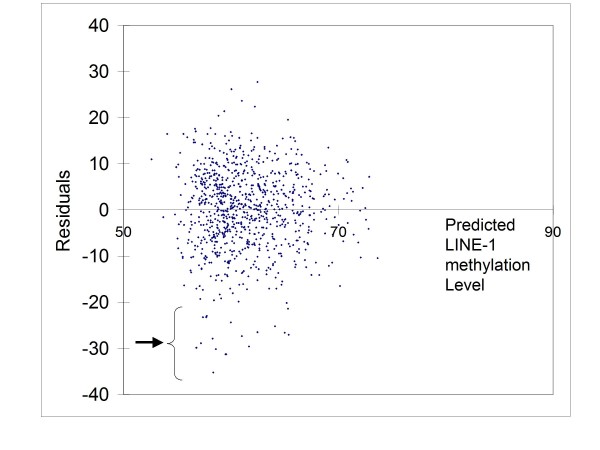
Residuals plot of multivariate linear regression model to predict LINE-1 methylation in 869 colorectal cancers. Each dot represents each case. The x axis represents LINE-1 methylation level predicted by the regression model, and the y axis represents the residuals (observed LINE-1 methylation level minus predicted LINE-1 methylation level by the regression model). A distribution of the residuals is approximately normal across predicted LINE-1 methylation levels, except for the presence of outliers (arrow). The arrow suggests the presence of a distinct group of tumors, separate from the normal and homoscedastic distribution around the 0 residual line.